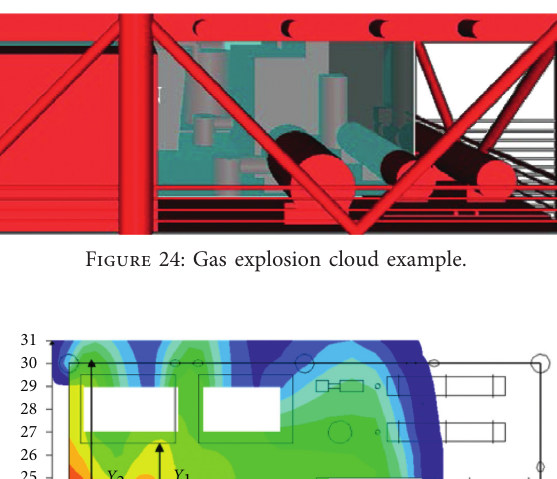
1 , X 2 , Y 1 , and Y 2